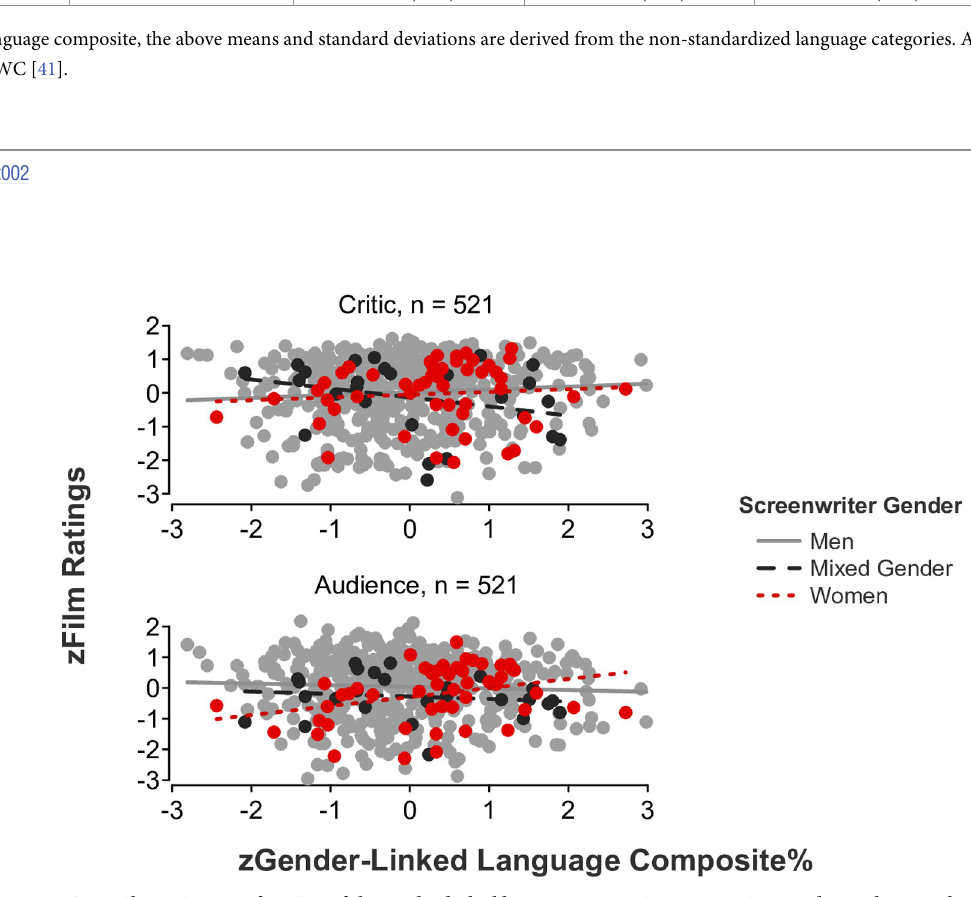
Fig 1. Film ratings as a function of the gender-linked language composite, screenwriter gender, and rater role.